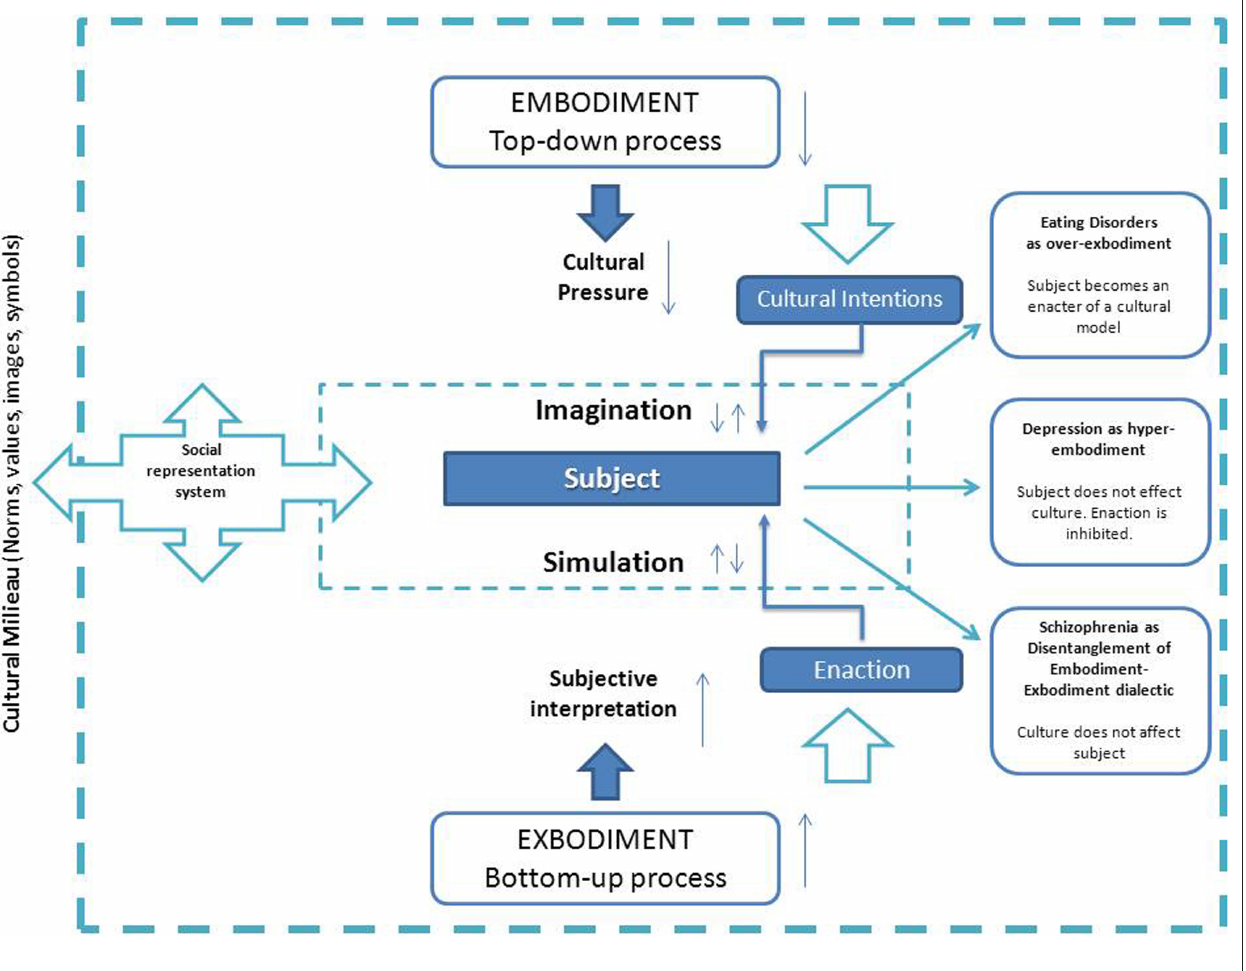
FIGURE 1 | Embodiment–exbodiment in cultural dialectic